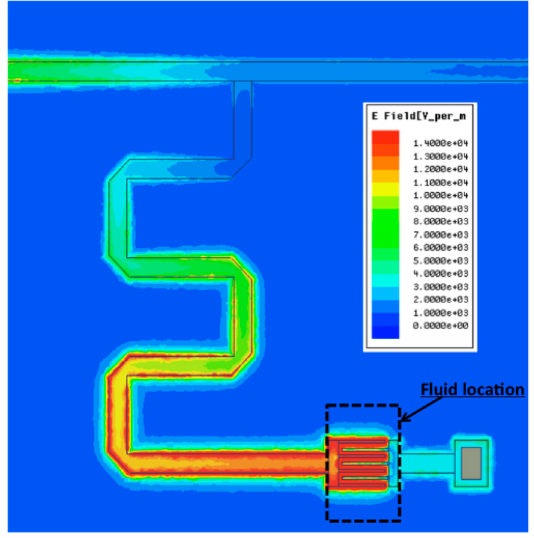
Figure 2. Simulated electric field intensity at the resonance.